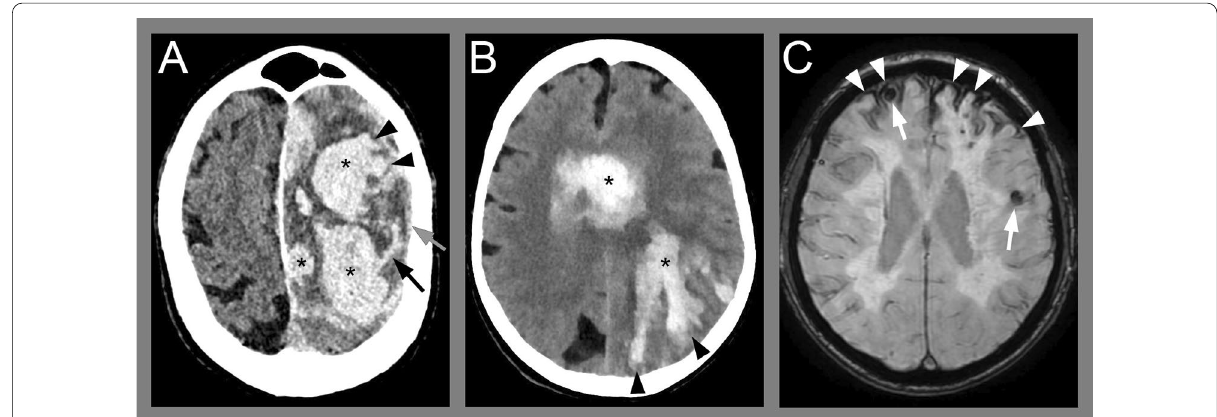
Fig. 4 Cerebral amyloid angiopathy imaging features. Examples of imaging features of cerebral amyloid angiopathy (CAA) on CT and MRI. CT imaging predictors of CAA (panel A and B ) showing ICH with multifocal components (black asterisks), finger-like projections (black arrowheads),